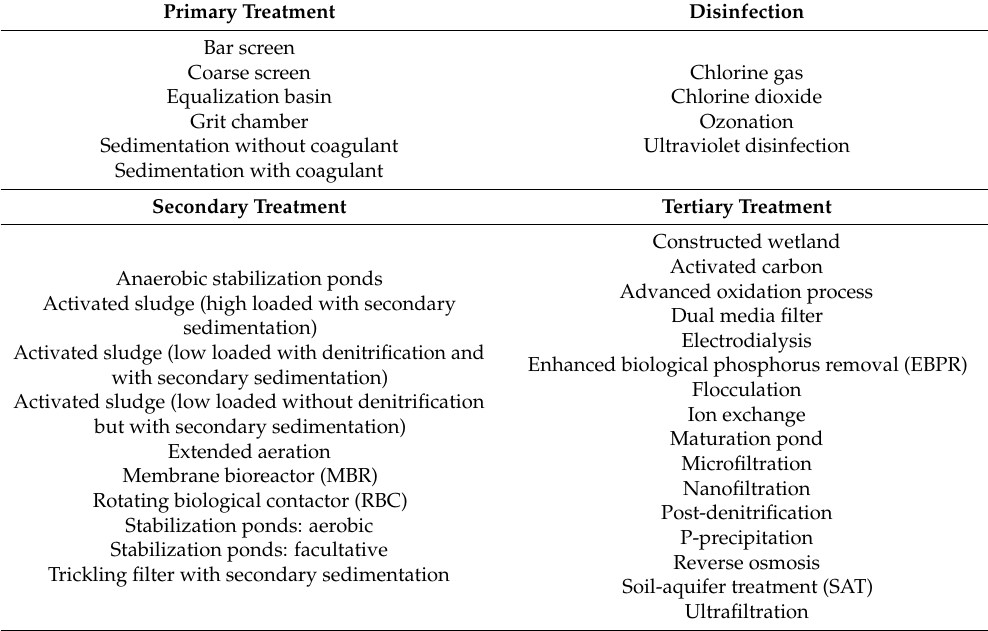
Table 2. List of unit processes considered in the